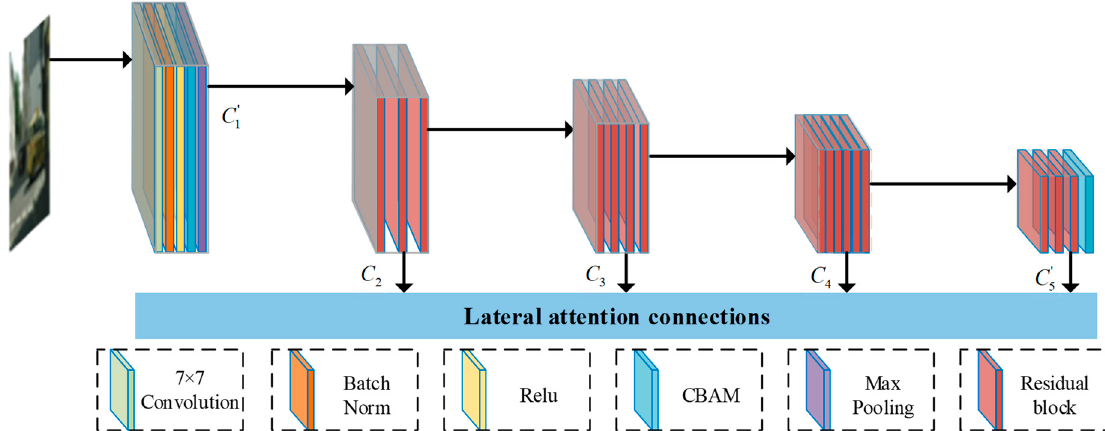
Figure 2. The architecture of feature extraction. We exploit ResNet-50 with convolutional block attention module (CBAM) to extract instance related features.